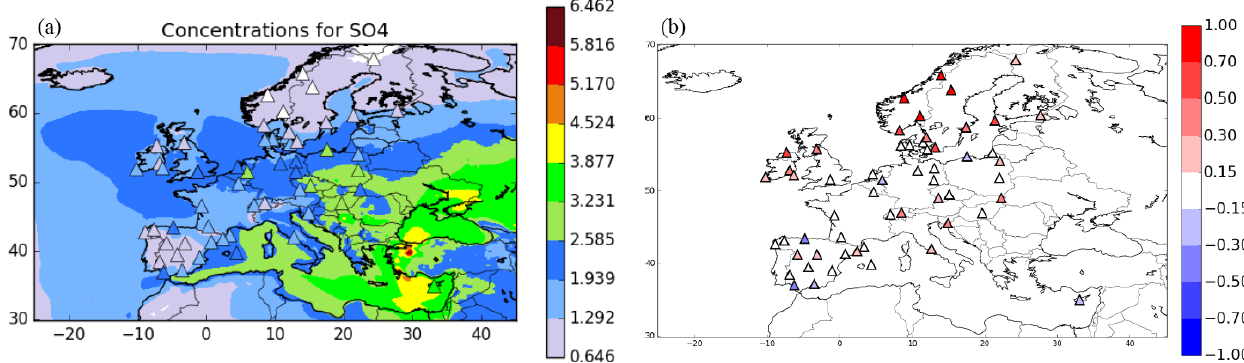
Figure 3. Modeled concentrations (in µgm − 3 ) and MFB for SO 2 − and to the MFB value in panel (b)